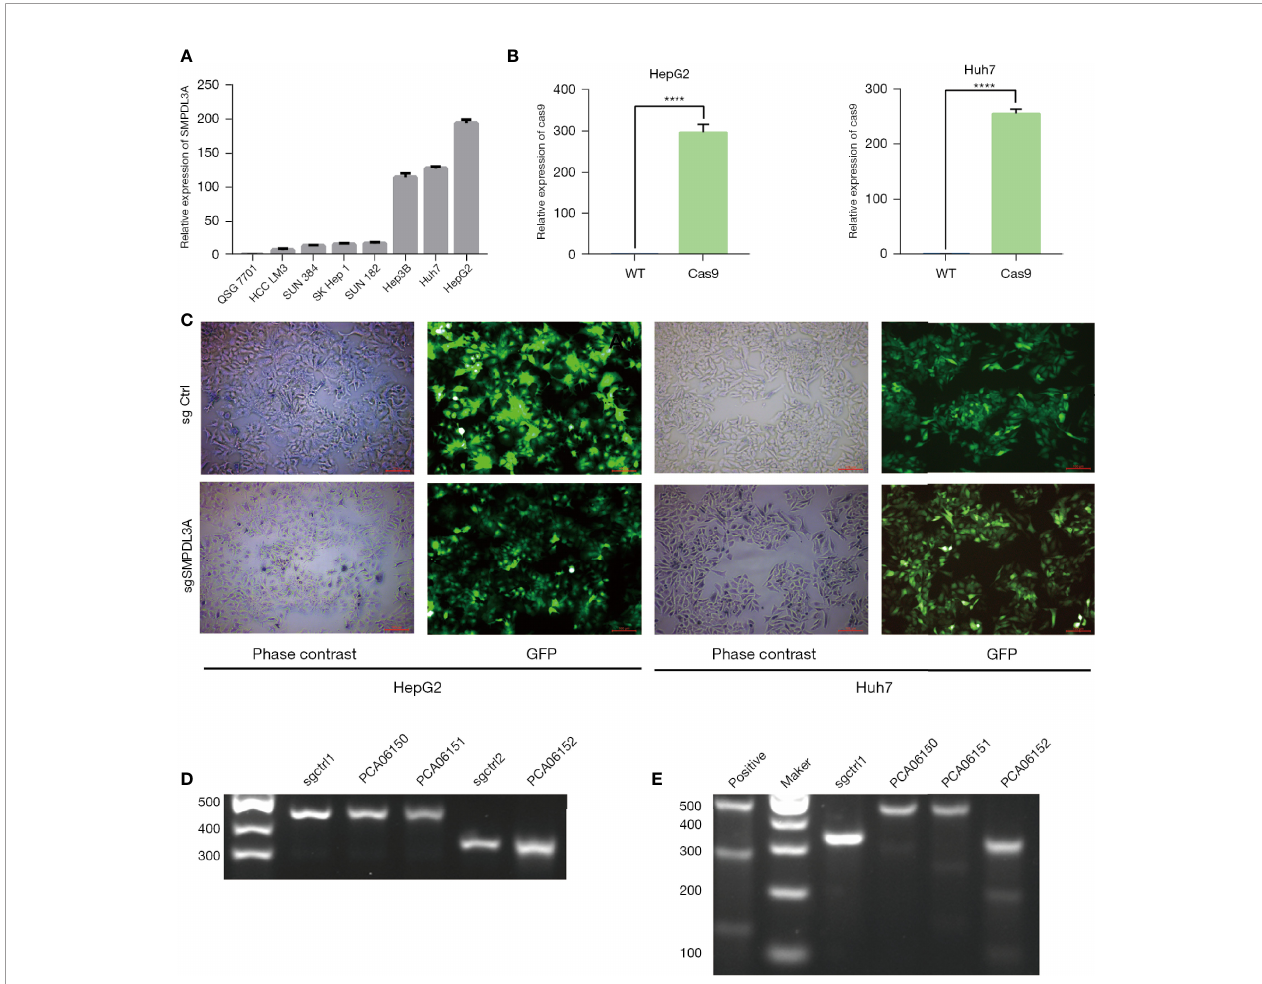
FIGURE 4 | The CRISPR/Cas9 dual-vector lentivirus knocked out the target sequence of theSMPLD3A gene. (A) SMPDL3A expression levels in HCC cell lines and normal liver cell line. (B) CAS9 overexpression was con fi rmed by QPCR assays in HepG2 and Huh7 cell lines (****P<0.0001). (C) Fluorescence microscopy images taken under white light exposure and excitation of green light. Infection ef fi ciency was almost 100%. (D) The agarose gel electrophoresis fi gure of DNA hybridization products. sgctrl1 and sgctrl2 were used as negative control. (E) The agarose gel electrophoresis fi gure of after T7E1 digested . The expected positions of DNA bands cleaved by T7E1in the samples of . PCA06151and PCA06152. sgctrl1 was used as negative control, positive was used as positive